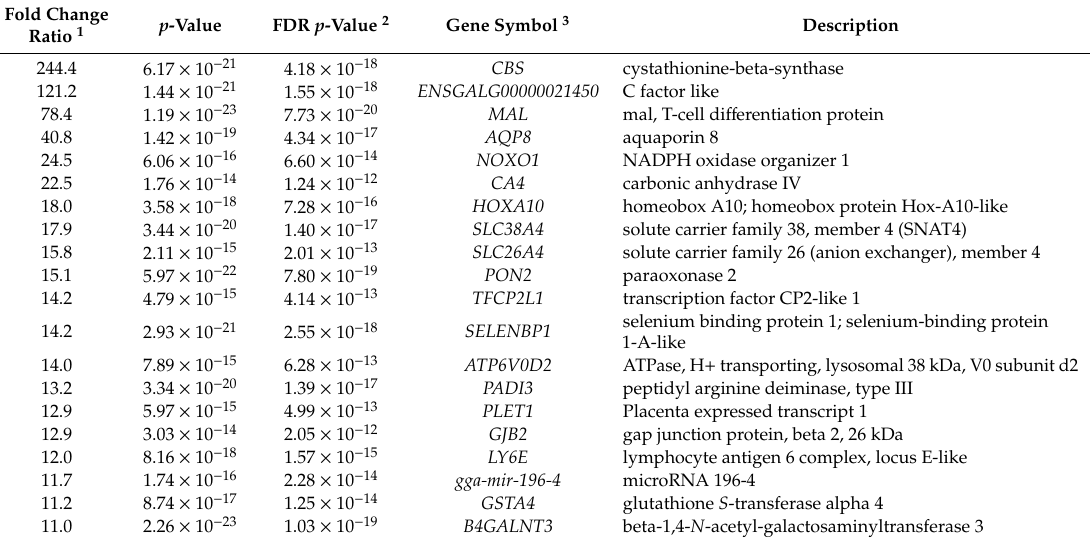
Table 2. List of the first 20 di ff erentially expressed transcripts in cecum of broiler chickens ranked by fold change ratio (FCR), compared to the jejunal